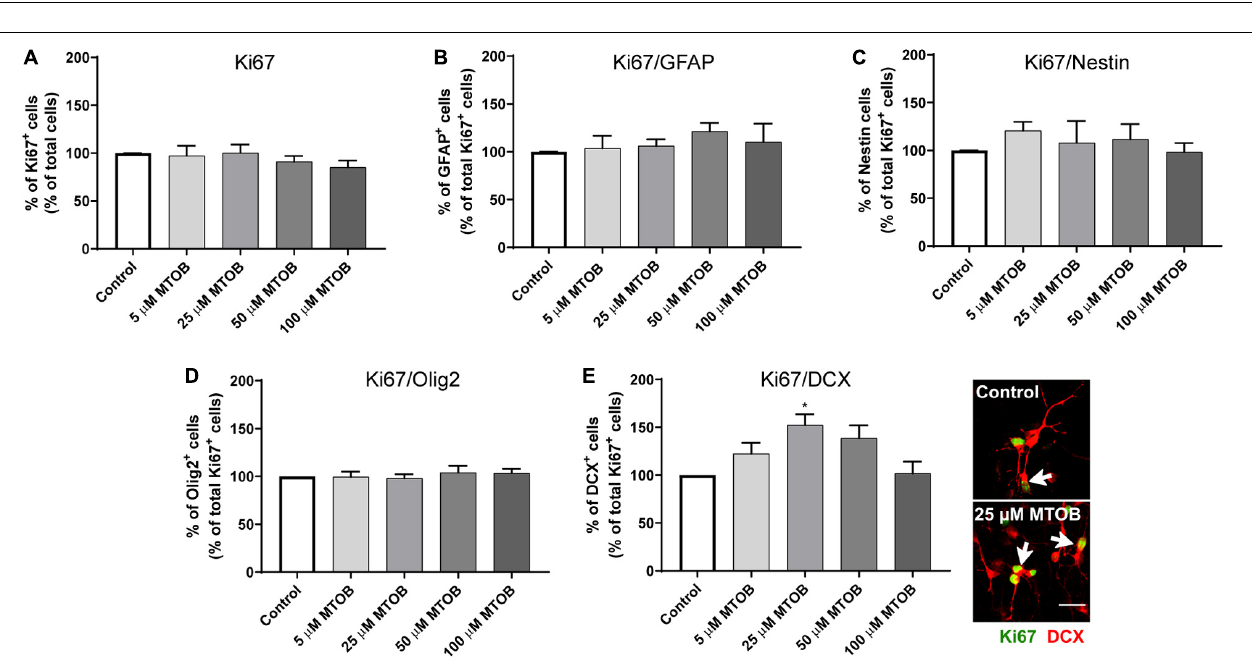
FIGURE 4 | High concentrations of MTOB induce SVZ cell death. (A,B) Percentage of (A) condensed/fragmented nuclei and (B) PI + cells assessed 48 h after MTOB treatments. Data are expressed as mean ± SEM. (A) n = 2-8 and (B) n = 4 independent experiments. * p < 0.05 when compared to control, using one-way ANOVA, followed by Dunnett’s multiple comparison test. Representative images of Hoechst-labeled nuclei are shown next to the graph, with white arrows highlighting condensed/fragmented nuclei. Scale bar: 20 µ m.